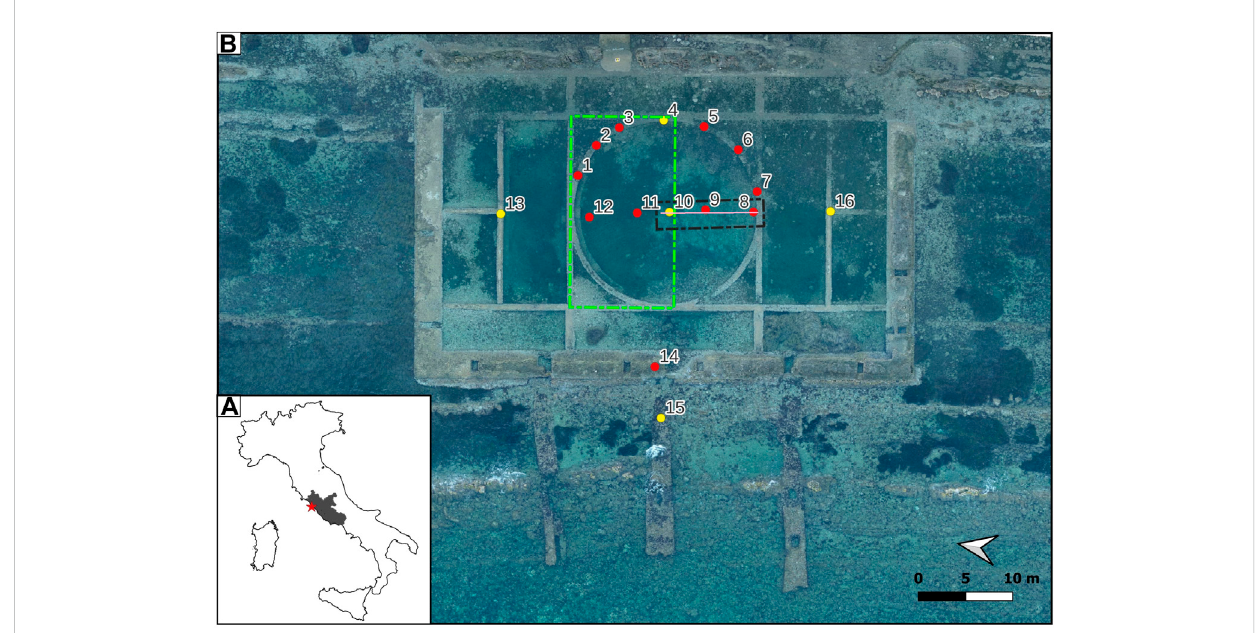
FIGURE 1 (A) Location of the study area on the Italian Tyrrhenian coast. (B) Orthophoto of the Punta della Vipera fi sh tank. The red and yellow dots show the distribution of the CPs and GCPs, respectively. The green rectangle and black rectangles point out the area of interests for UAS-based (AoI1) and underwater-based (AoI2) surveys, respectively. The pink line (between target 8 and 10) represents the cross-section from which the topo-bathymetric pro fi les were extracted. Note: the coastline is situated East (top of the fi